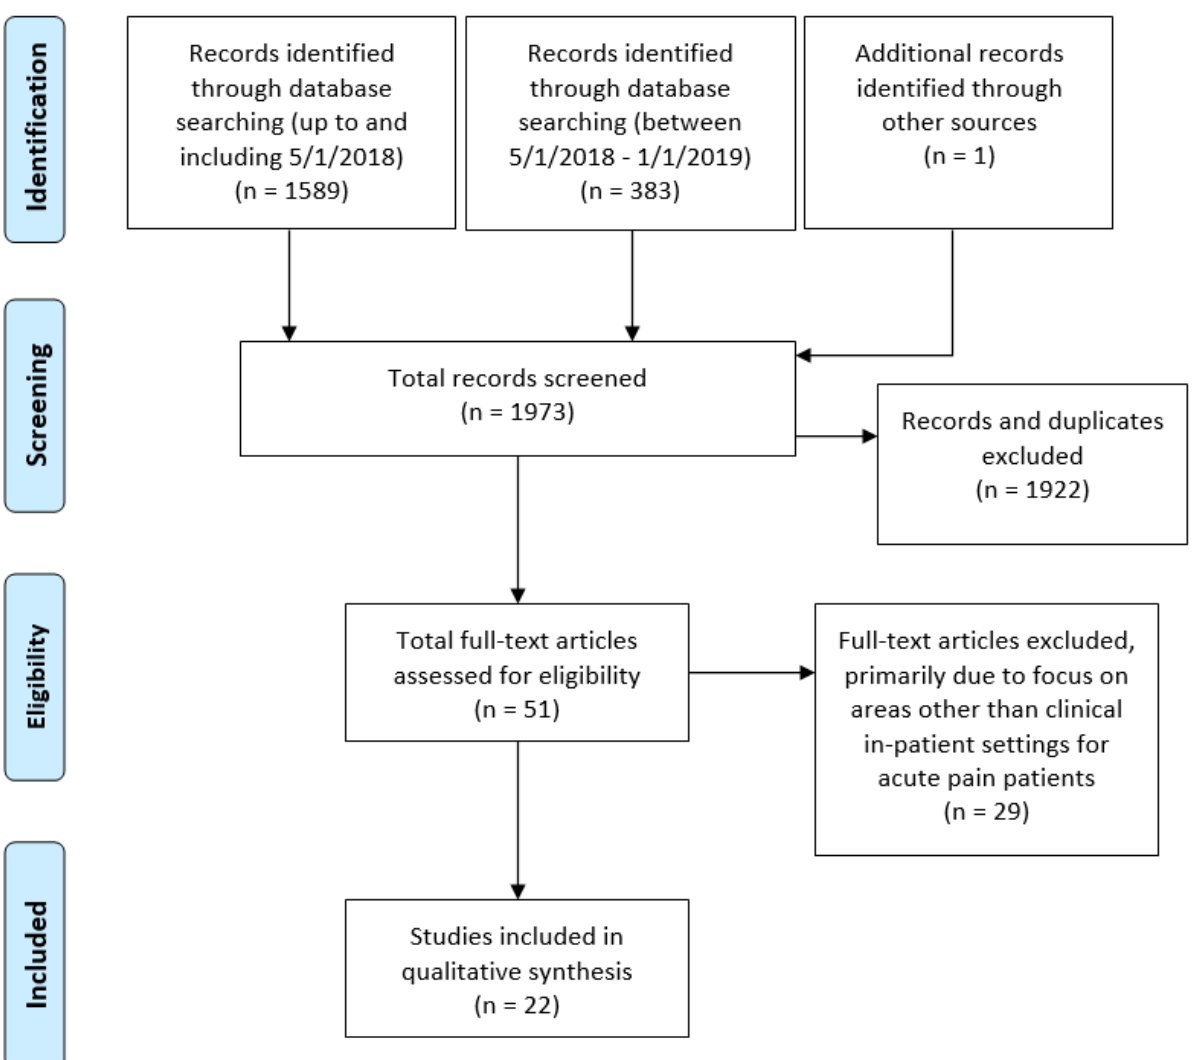
Figure 1. PRISMA flow